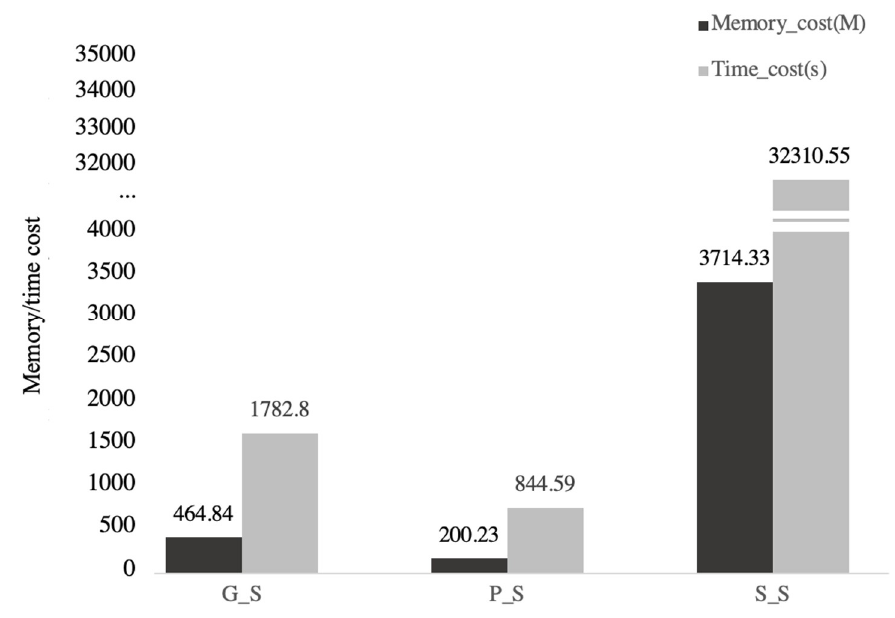
Figure 8. Memory / time cost of G_S, P_S and Figure 8. Memory/time cost of G_S, P_S and S_S.